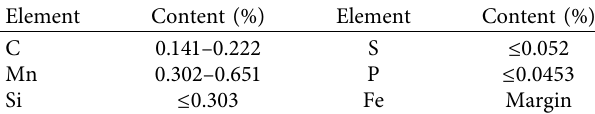
Table 1: Q235 steel composition (mass